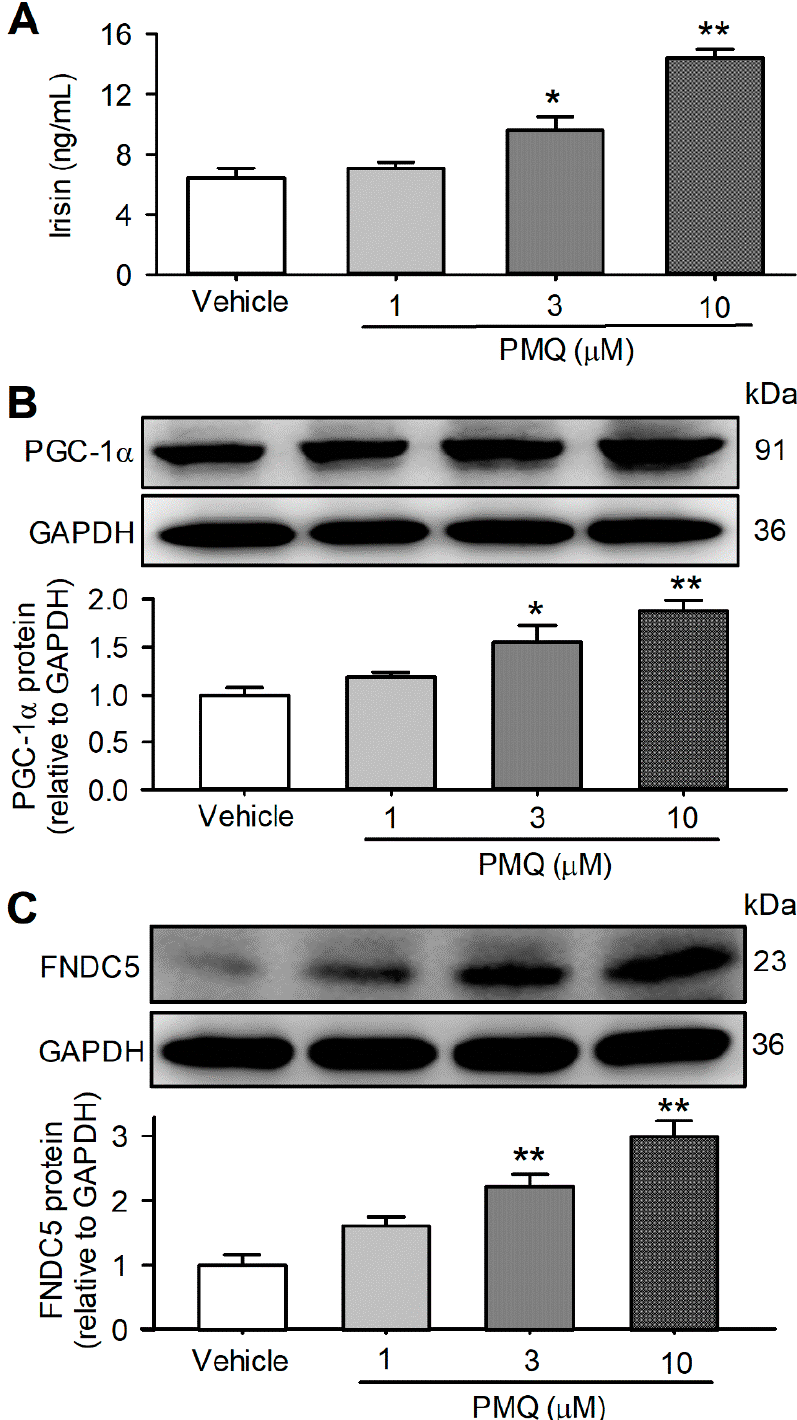
Figure 4. PMQ increases irisin secretion and upregulates the expression of PGC-1 α and FNDC5 in C2C12 myotubes. C2C12 myotubes were treated with various concentrations of PMQ (1, 3, 10 μ M) or vehicle for 16 h, and cultured for an additional 24 h in regular DMEM. Then the conditioned media were collected. ( A ) Irisin levels in the conditioned medium. n = 6. ( B , C ) Protein levels of PGC-1 α and FNDC5 in C2C12 myotubes. n = 3. * p < 0.05, ** p < 0.01 vs. vehicle. Data are expressed as means ± SEM.